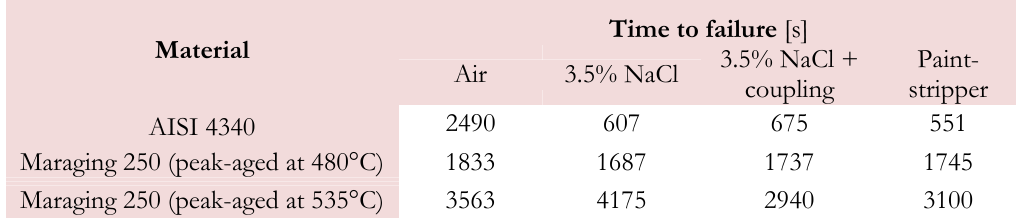
Table 2: Average (3 specimens) example of measured time to failure for SSRT conducted on the three materials loaded in different environments.